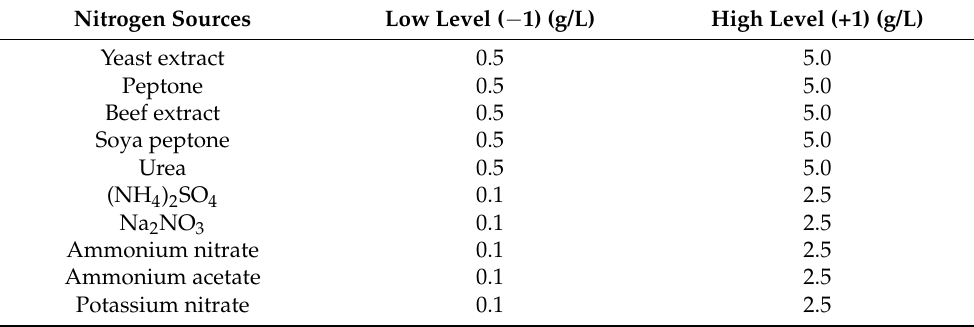
Table 2. The low and high levels of nitrogen sources used in the PB design.